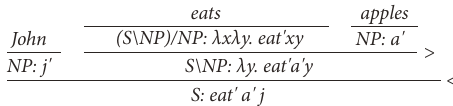
Figure 2: CCG derivation of “John eats